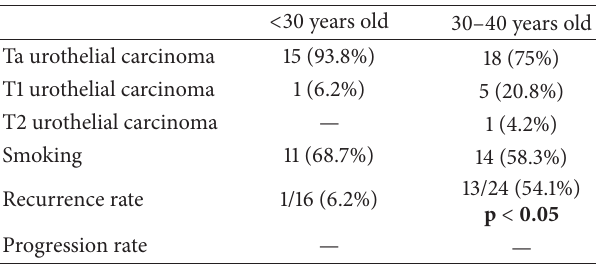
Table 2: Clinical and pathological results of patients for different age